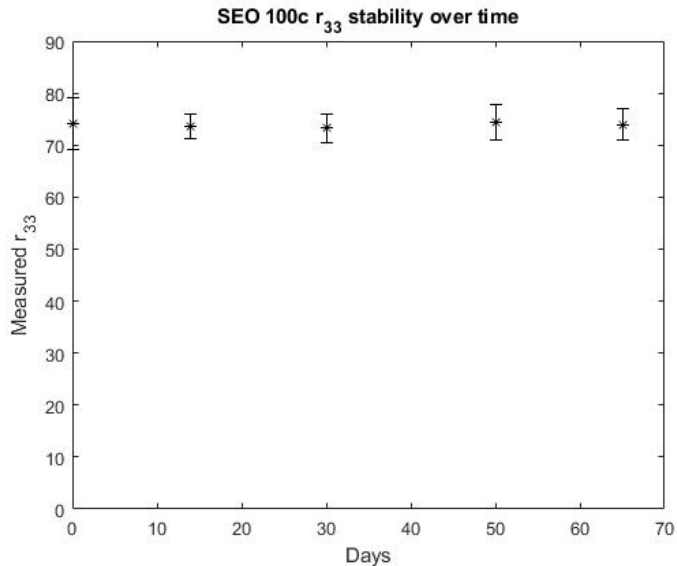
Figure 8. The r 33 stability of SEO100c over time.